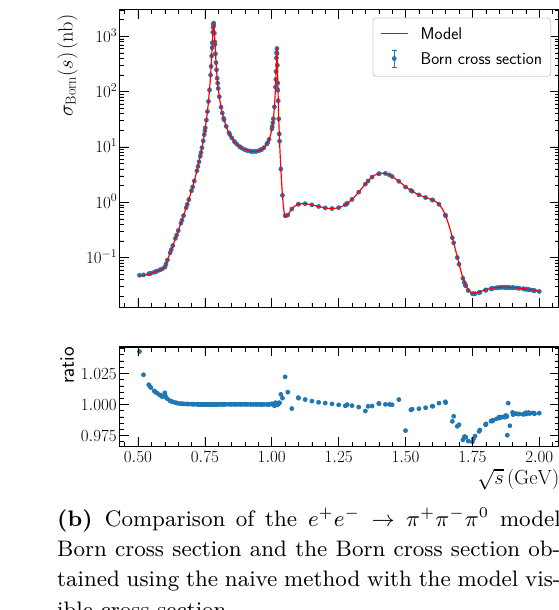
(b) Comparison of the e + e − → π + π − π 0 model Born cross section and the Born cross section ob- tained using the naive method with the model vis- ible cross section.